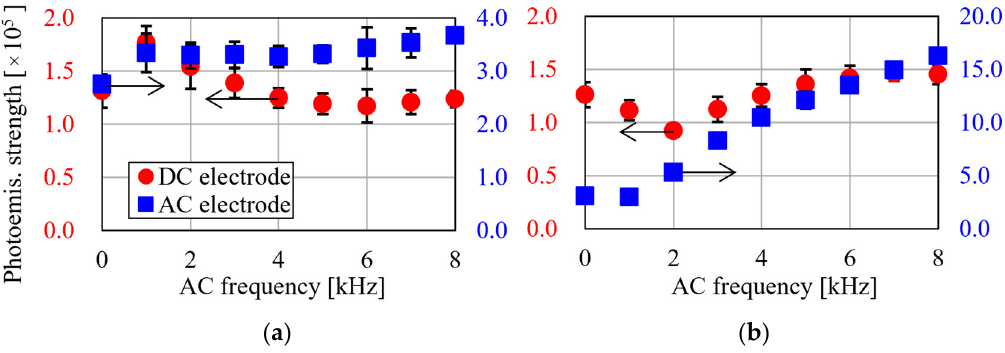
Figure 19. Photoemission strength versus the frequency of the AC voltage when the AC voltage was 10 kV pp and the DC voltage was 14 kV in the ( a ) CD-PA and ( b ) TED-PA.